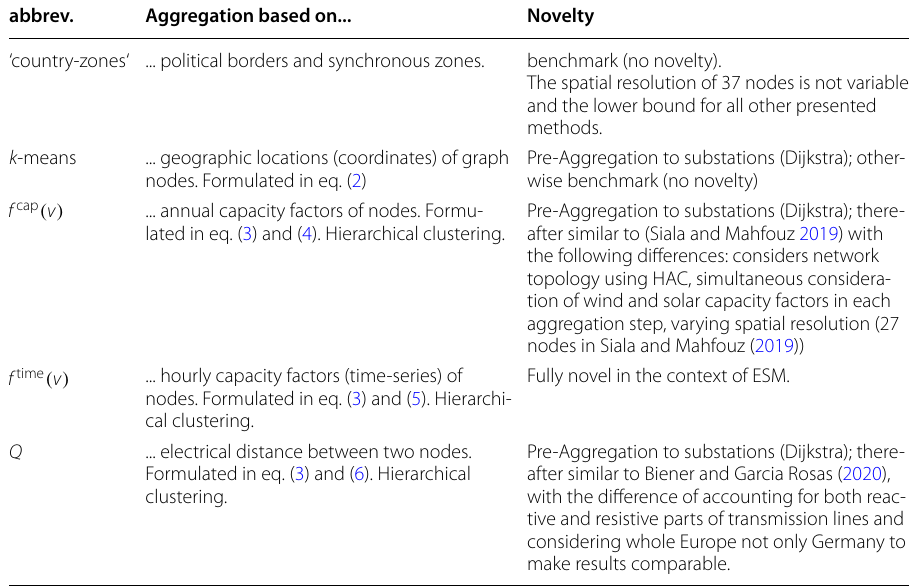
Table 1 Abbreviations and novelty declaration for the applied clustering methods. Each is discussed in an own chapter in the methods chapter, see Methods abbrev. Aggregation based